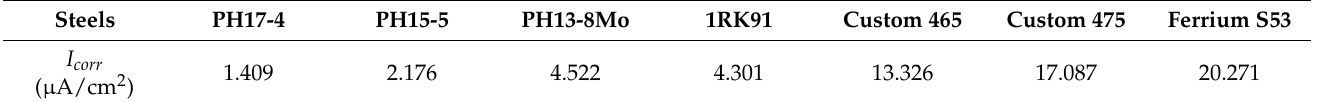
Table 5. Corrosion current density of various PHSS